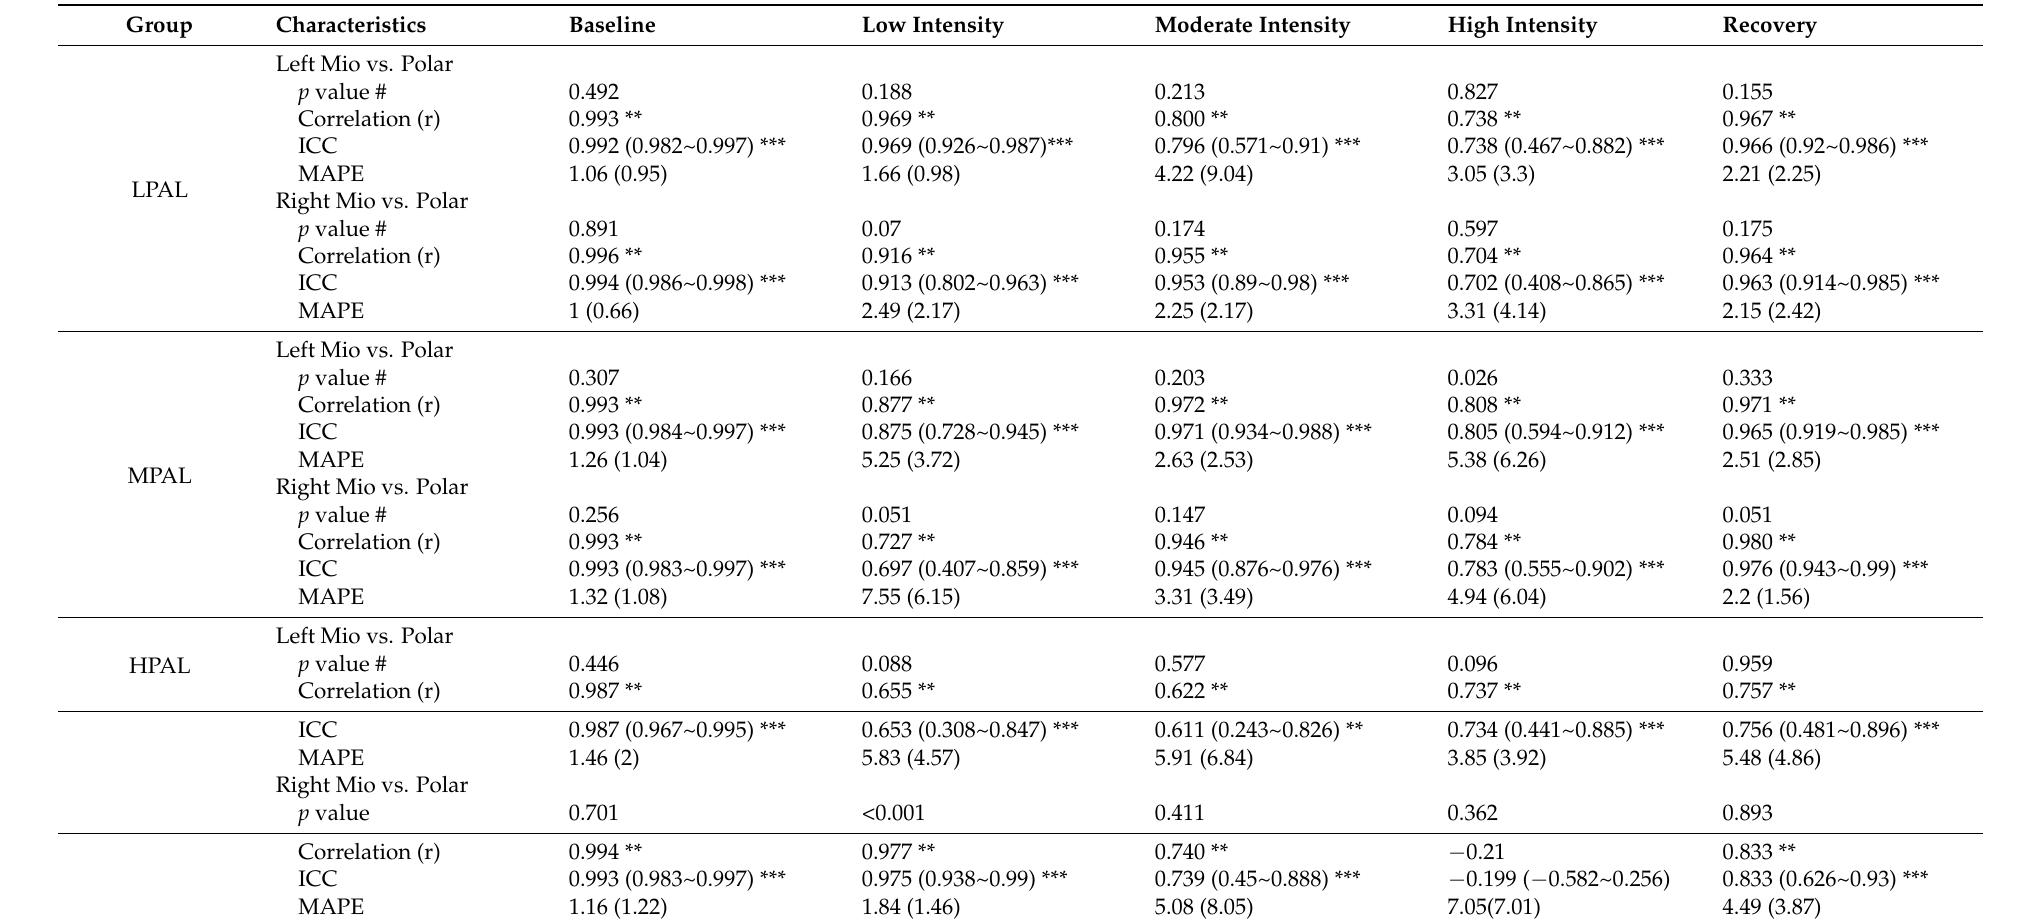
Table 6. Validity of Mio versus